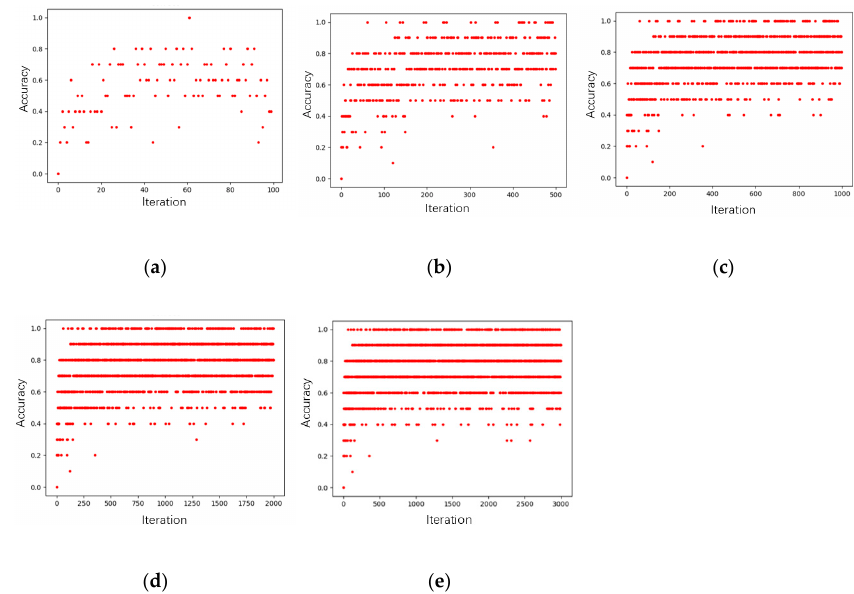
Figure 3. Accuracy rates with different training epochs. ( a ) Accuracy rates with 100 training epochs; ( b ) accuracy rates with 500 training epochs; ( c ) accuracy rates with 1000 training epochs; ( d ) accuracy rates with 2000 training epochs; ( e ) accuracy rates with 3000 training epochs. Table 1. Comparison of the accuracy rate with different training times.